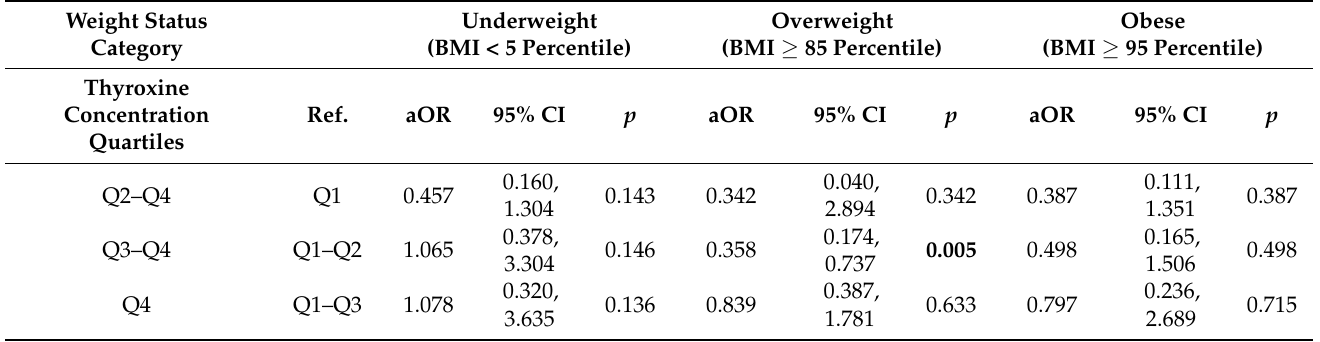
Table 4. Dependence of weight status at 24 months corrected age on different thyroxine concentration